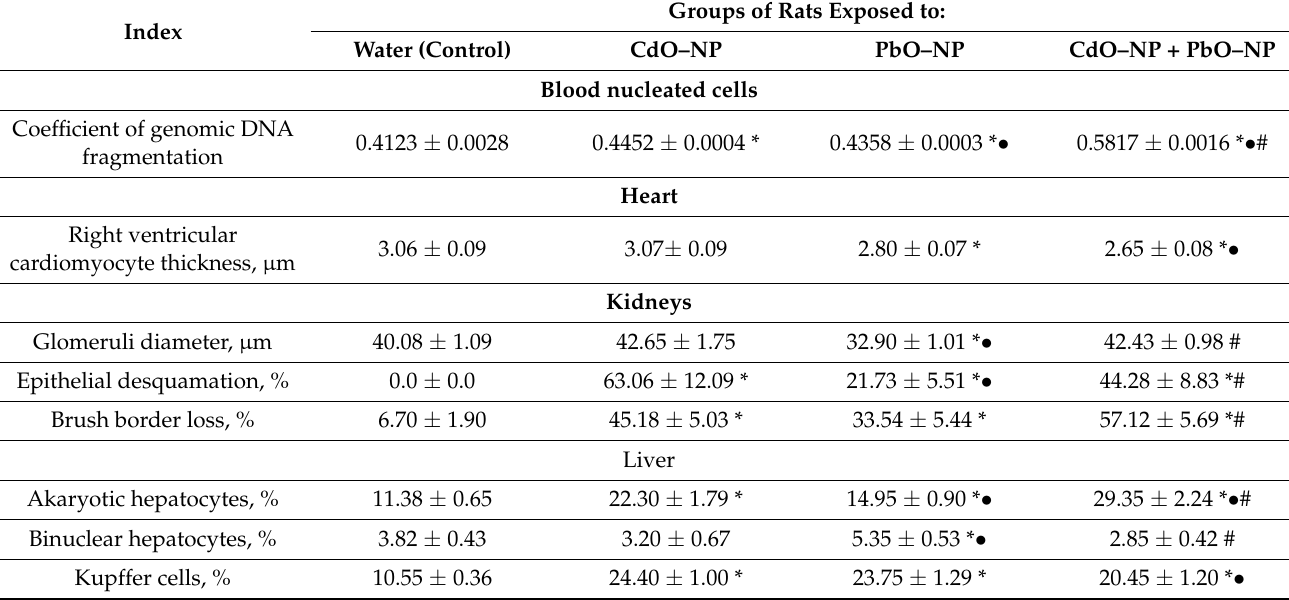
Table 1. Genomic DNA fragmentation coefficient in circulating blood nucleated cells and some morphometric indices of the heart, kidney and liver status in rats exposed to lead oxide (PbO–NP) and/or cadmium oxide (CdO–NP) nanoparticles (X ±